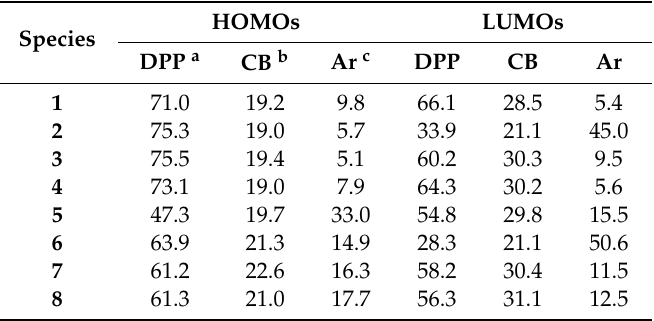
Figure 1. The electronic density contours of the frontier orbital for the studied compounds at the PBE0 / 6-31G (d,p) level. Table 1. The highest occupied molecular orbit (HOMO) and lowest unoccupied molecular orbit (LUMO) contributions of individual fragments (in%) to the frontier molecular orbitals (FMOs) of 1 – 8 at the PBE0 / 6-31G (d,p)